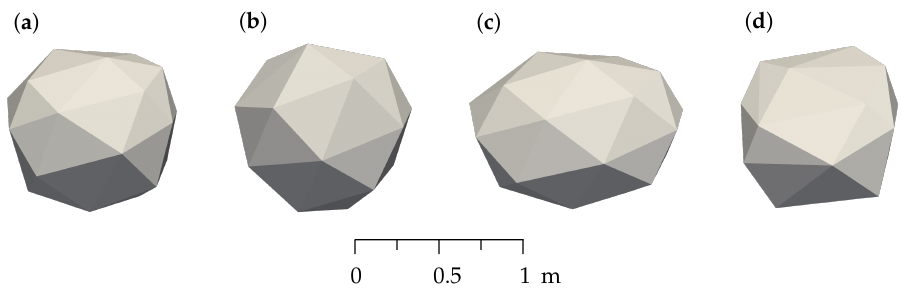
Table 2. Ratio of the minimum simulated size, k ms used in DEM simulations of gyratory and cone crushers.